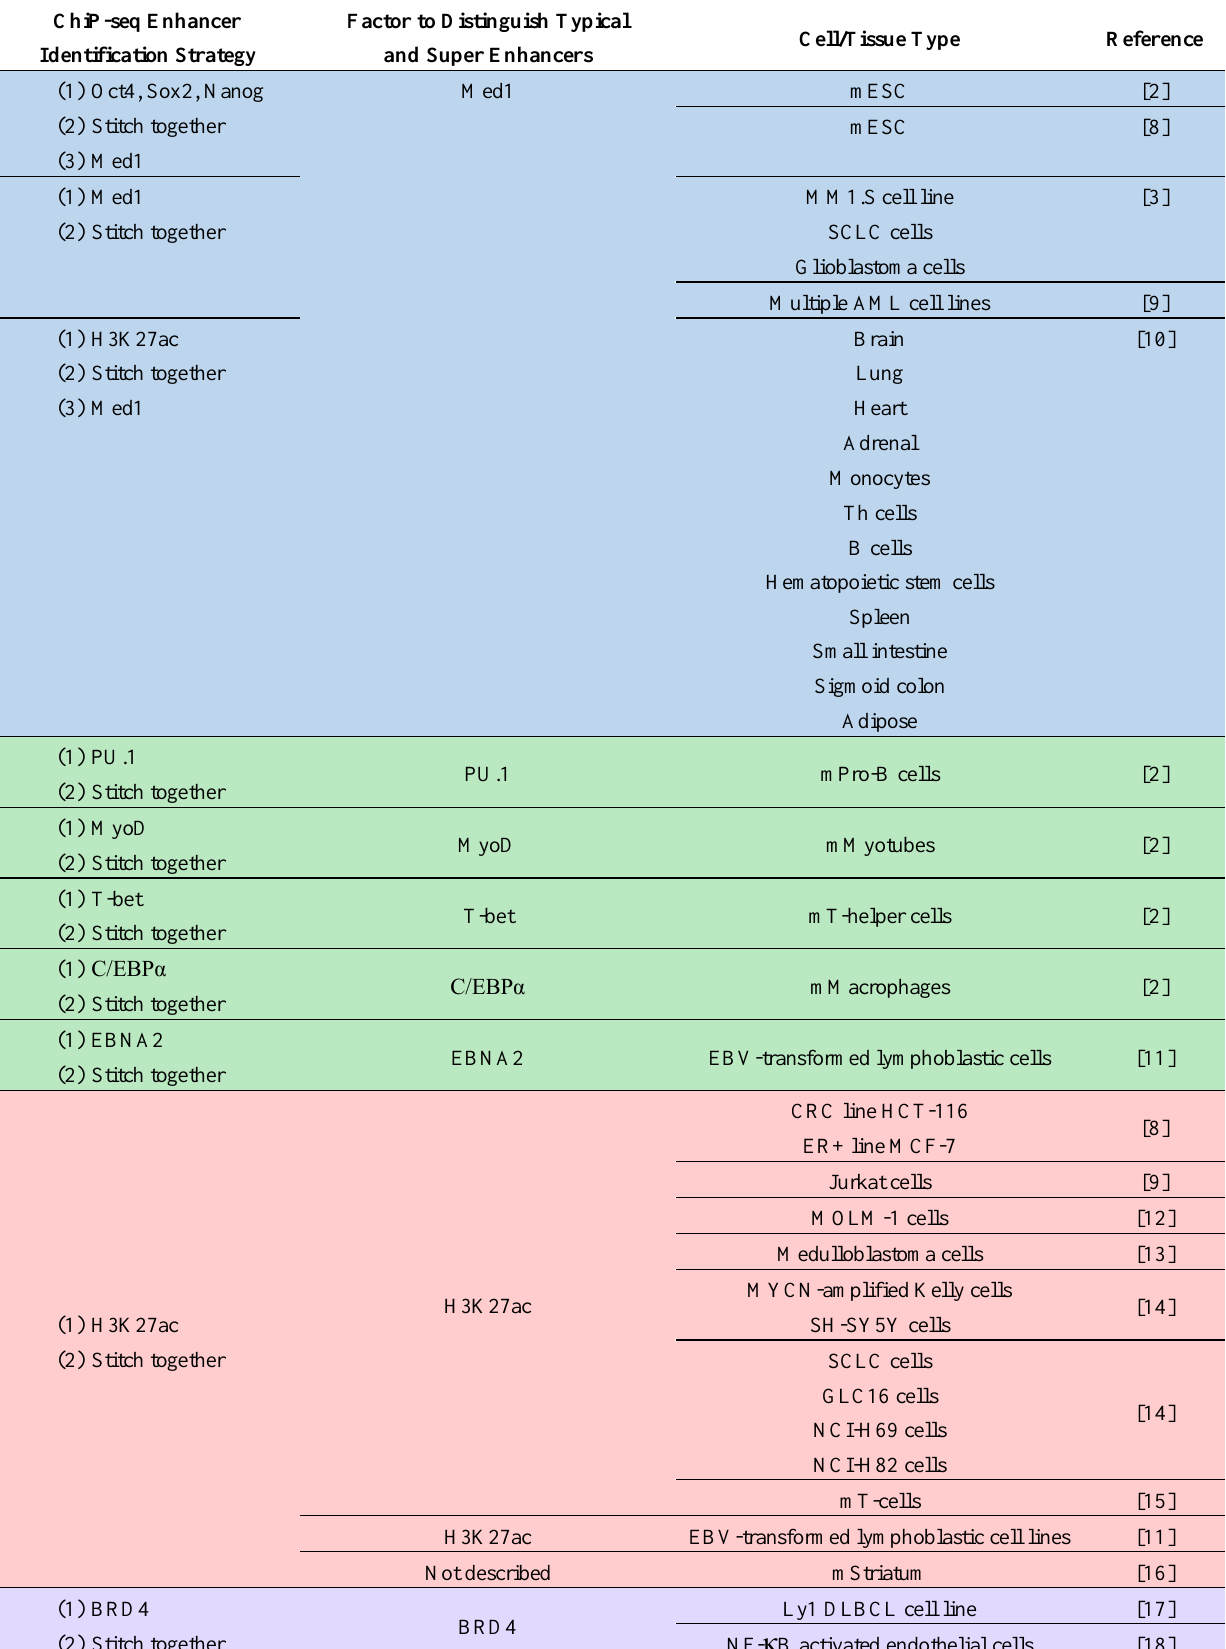
Table 1. Comparison of markers used to define super-enhancer